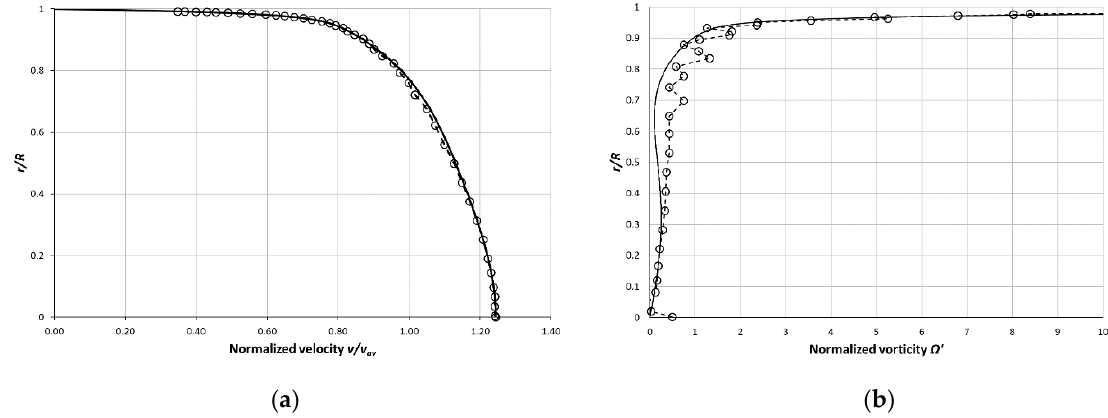
Figure 13. The analytical formula comparison with the experimental data (PSP) for Re = 31,577, using variables Ω (w) , D (1) , K, and N . Dashed line with circles represents the experimental data, the solid line is the analytical profile. ( a ) Normalized mean velocity profile, ( b ) Normalized vorticity distribution.